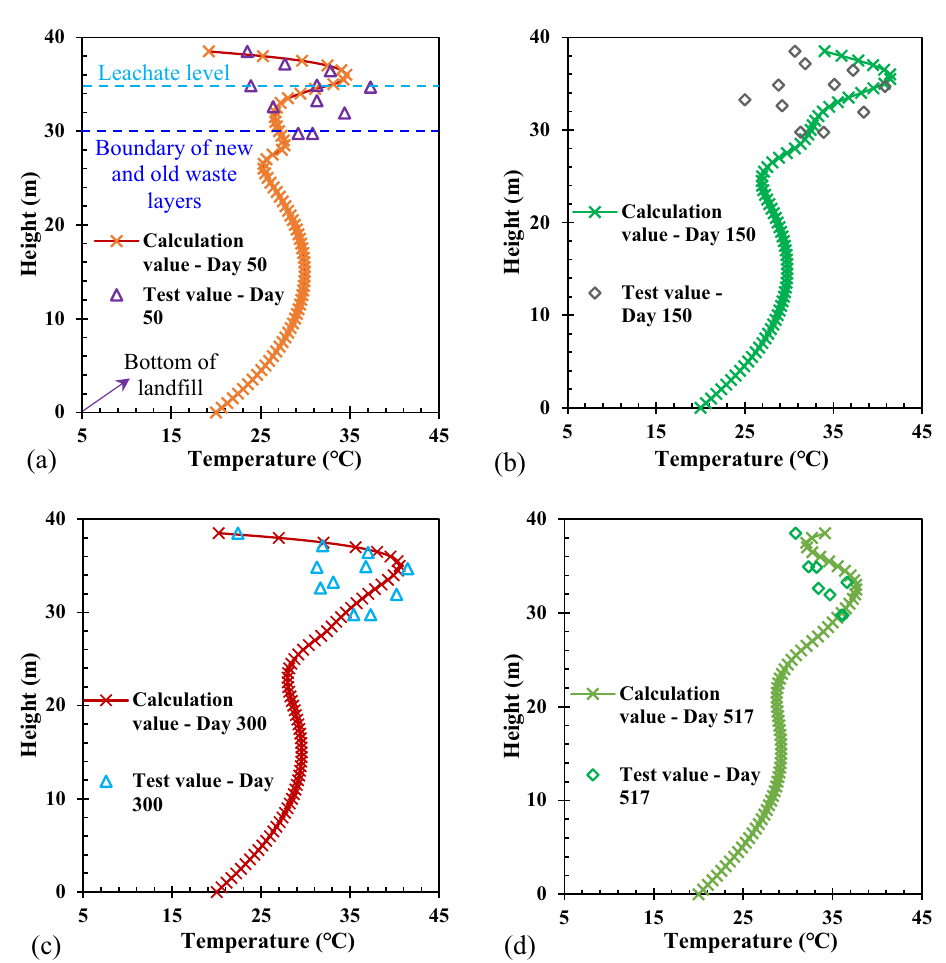
Figure 4. Comparison of the calculation and test values of the temperature with the height at the different times: ( a ) Day 50; ( b ) Day 150; ( c ) Day 300; ( d ) Day